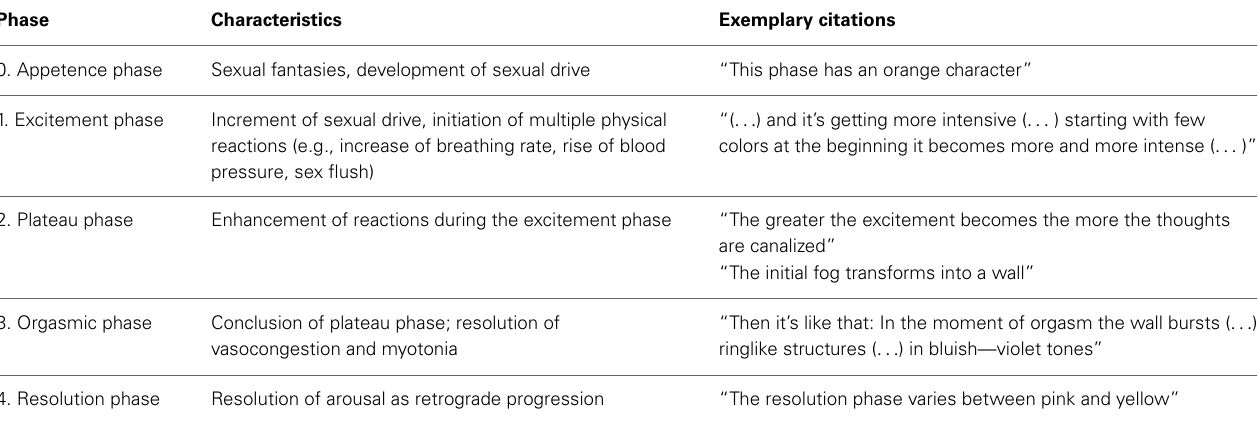
Table 3 | Exemplary citations by the synaesthetes questioned about the different phases of the human sexual response